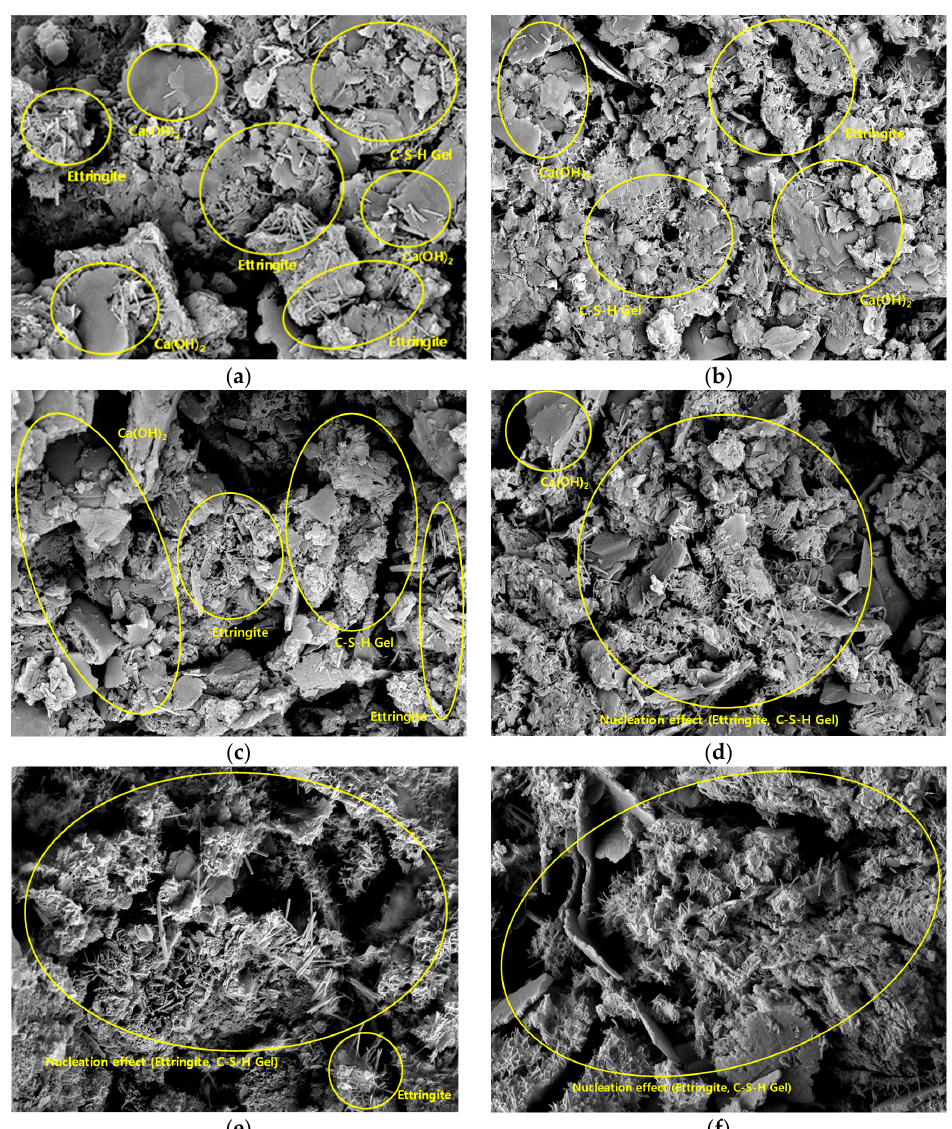
Figure 7. 28-d SEM images for different W/B values (×10,000). ( a ) W/B = 500%; ( b ) W/B = 450%; ( c ) W/B = 400%; ( d ) W/B = 350%; ( e ) W/B = 300%; ( f ) W/B = 250%.